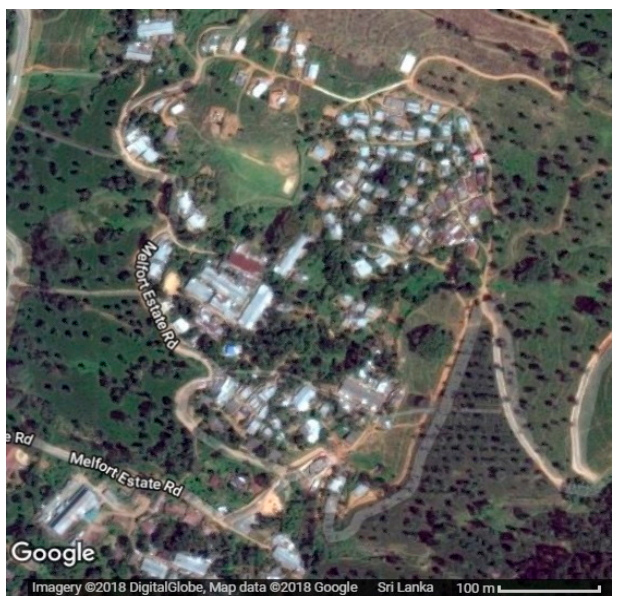
Figure 1. Map of the study area showing congested housing plots. (https://www.google.lk/maps/ Figure 1 . Map of the study area showing congested housing plots. Figure 1 . Map of the study area showing congested housing plots. place/Tea+Estate,+Pussellawa).